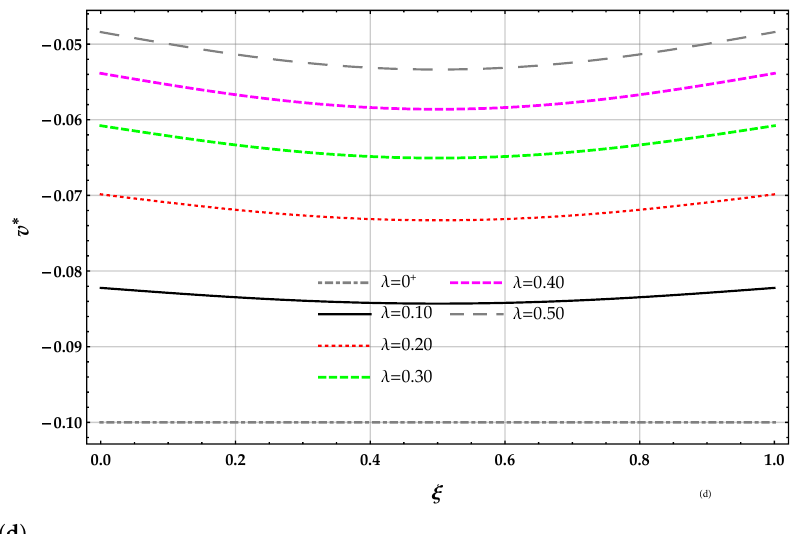
Figure 2. FF − q beam. Plots of the non-dimensional transverse displacement v ∗ of the surface of the elastic foundation for increasing values of the non-dimensional non-local parameter λ in the (cid:8) (cid:9) set 0 + ,0.1,0.2,0.3,0.4,0.5 with k ∗ = 10: ( a ) DD method, ( b ) MRD method, ( c ) zoom of the beam